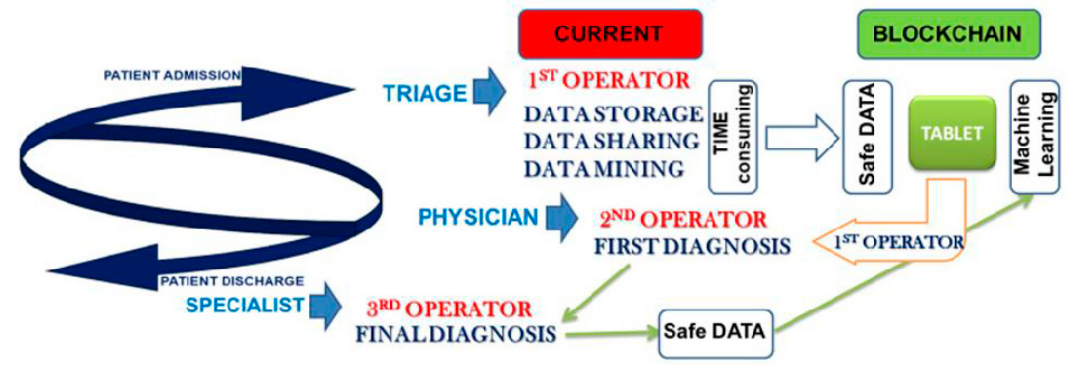
Figure 4. Insights into the clinical workflow derived from the blockchain-based model.